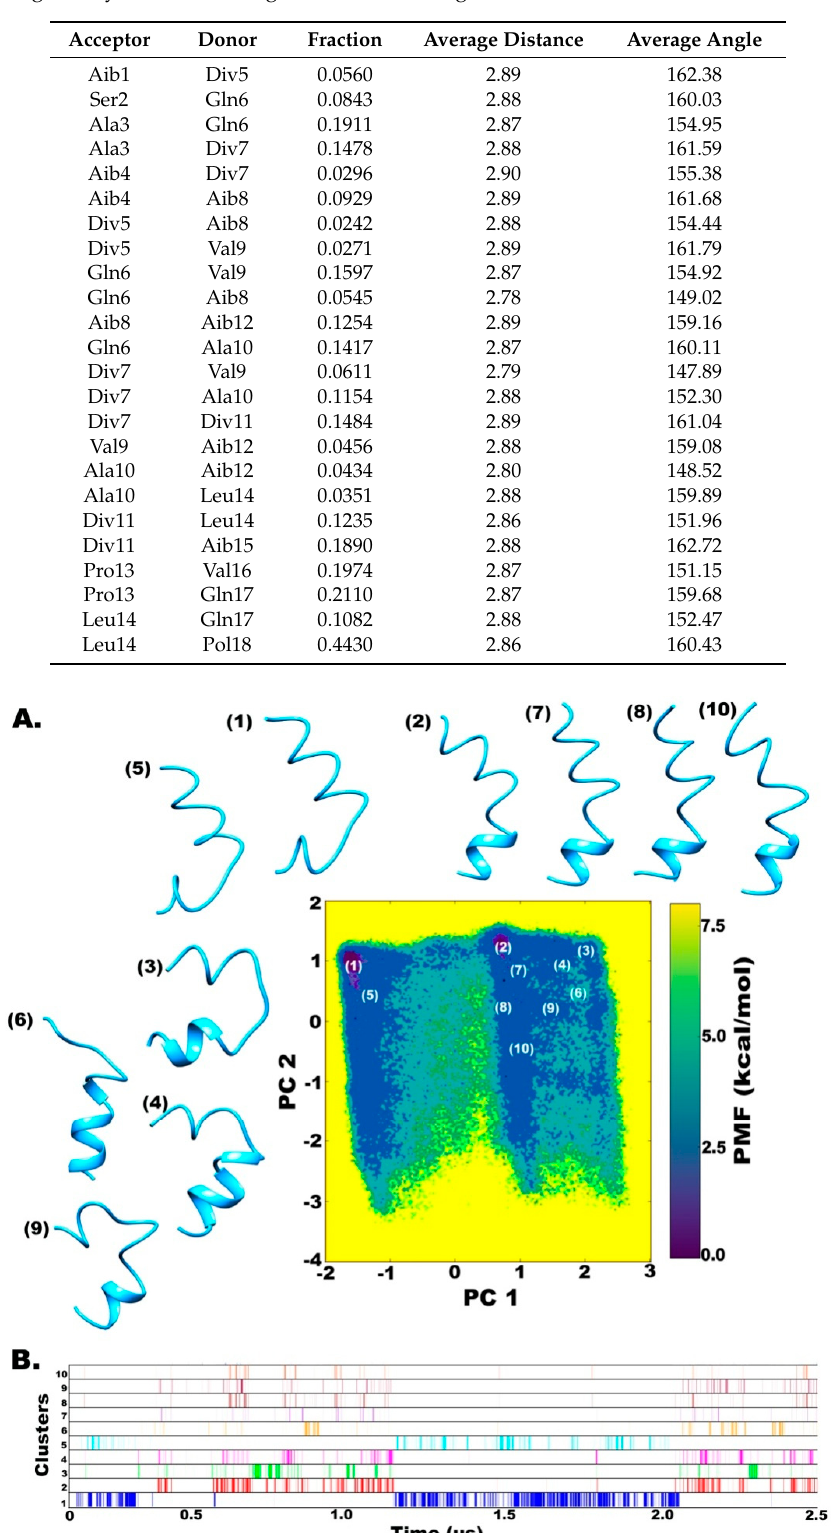
Table 2. Backbone H-bonds of TPN XIIc in explicit water solvent along with their frequency of occurrence given by fraction, average distance, and angle.